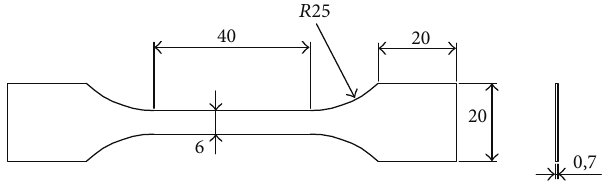
Figure 1: Sample dimensions for the tensile test.